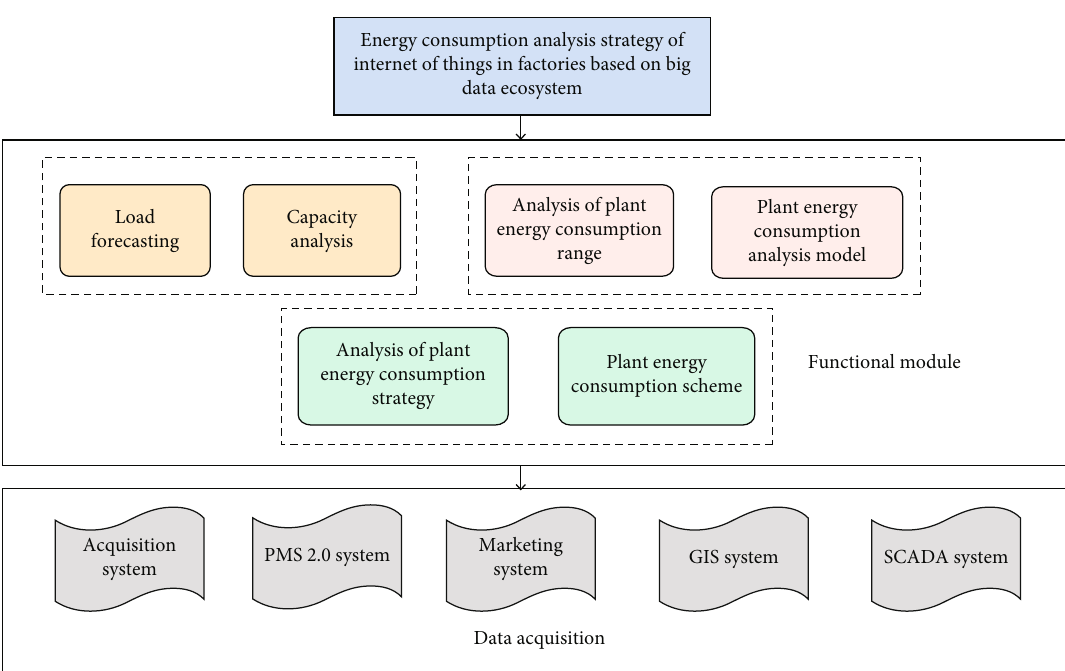
Figure 2: Analysis model diagram of IoT energy consumption in factory based on big data